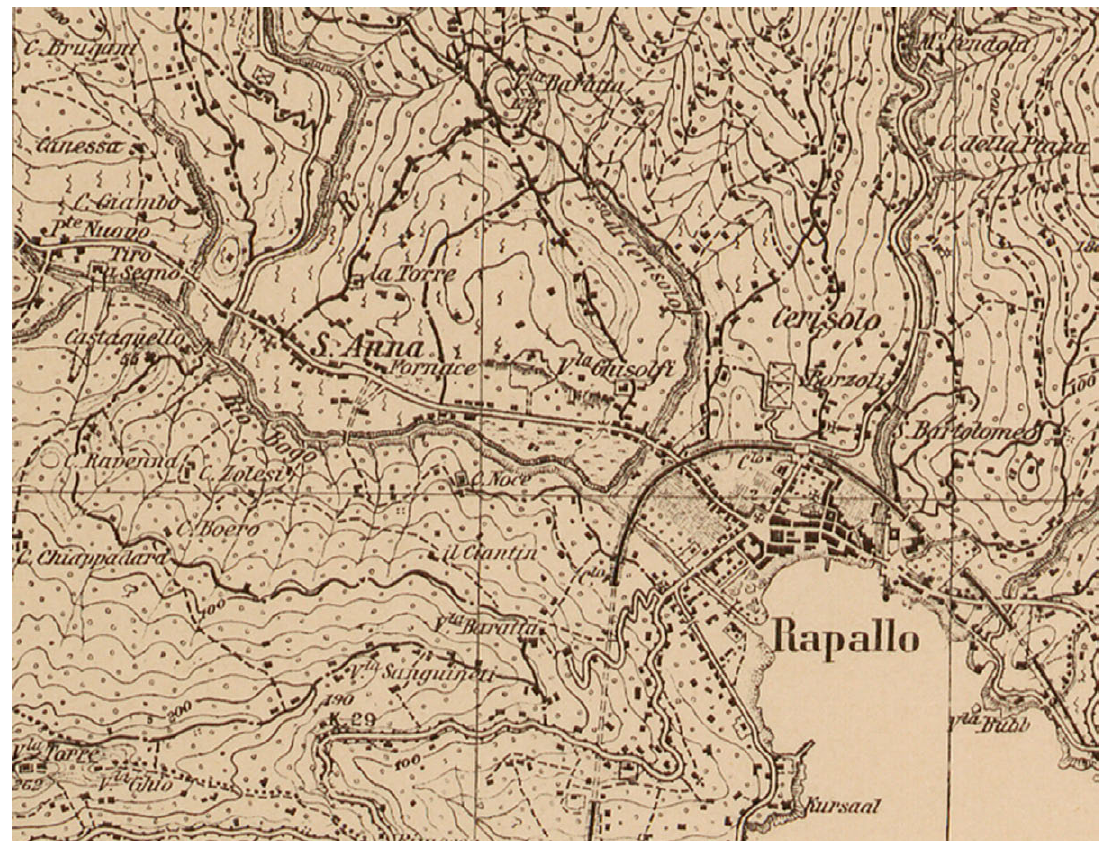
Fig. 7. Rapallo flood plain in the 1907s (after 1.25.000 scale map, IGMI